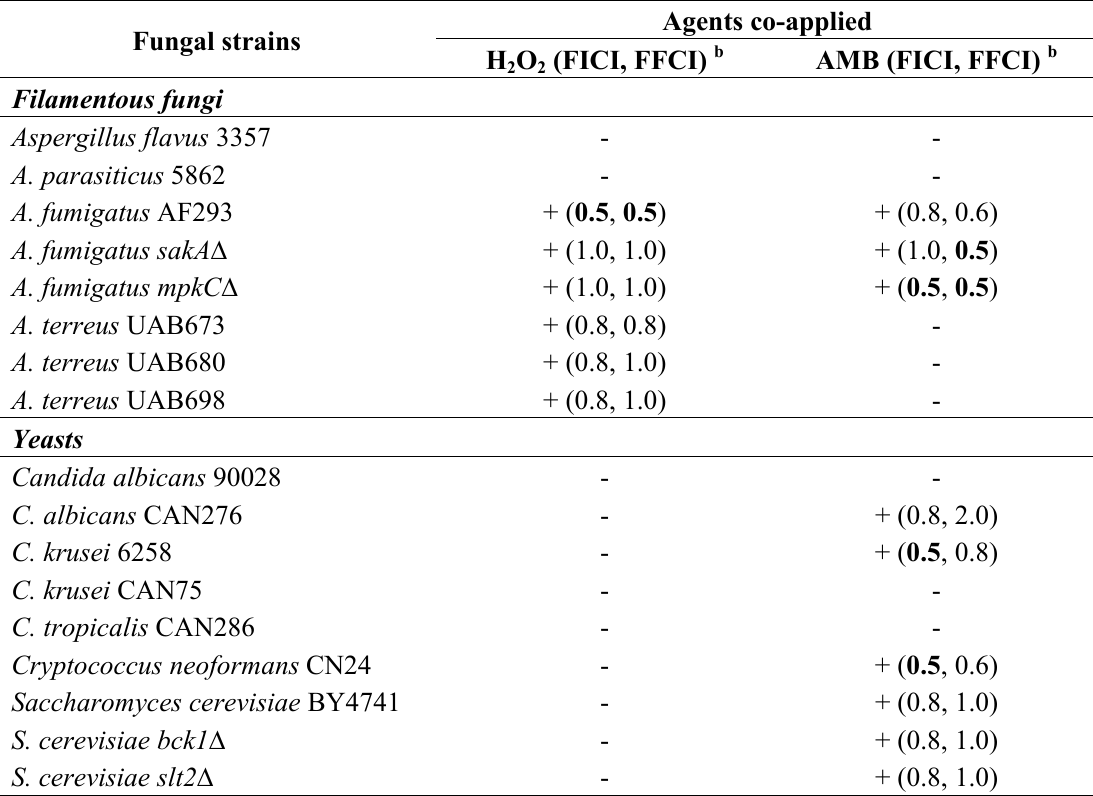
Table 5. Summary of responses of Aspergillus and yeast strains to the co-application of kojic acid with H O or AMB. 2 2